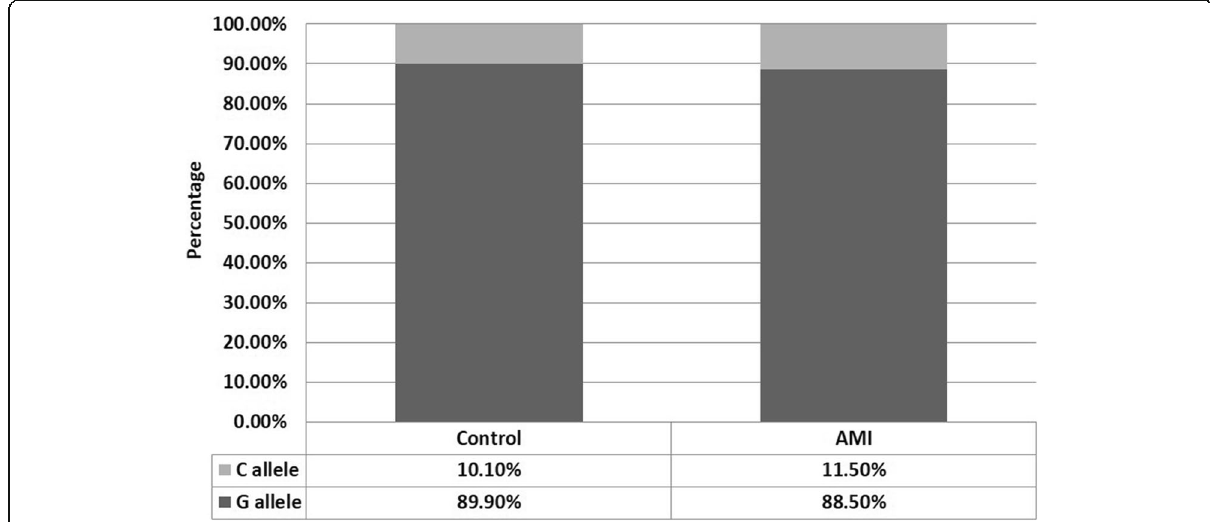
Fig. 5 Allele frequencies of the IL-6 gene among control subjects and AMI patients